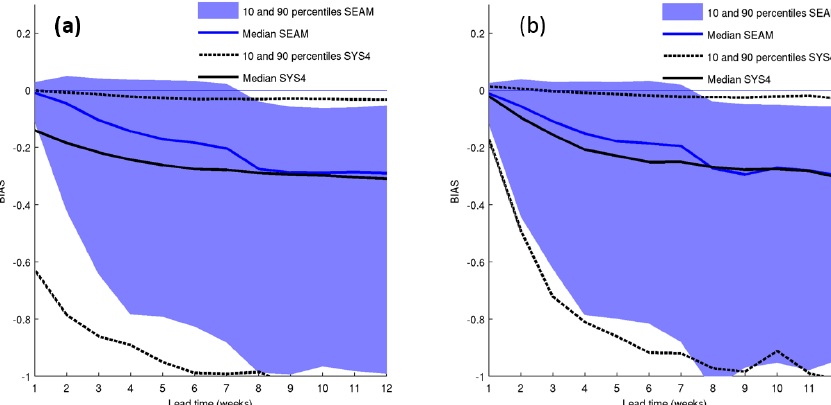
Figure 5. Mean relative error over all outlet points as a function of lead time in weeks (a) for all starting dates of the forecasts and (b) for the starting dates close to the beginning of the months. Negative values denote that the forecast is too wet in comparison with the CLIM run. The SEAM (SYS4) forecast is in blue (black) where the solid line denotes the median and the filled area (area between dotted lines) denote the 10 to 90th